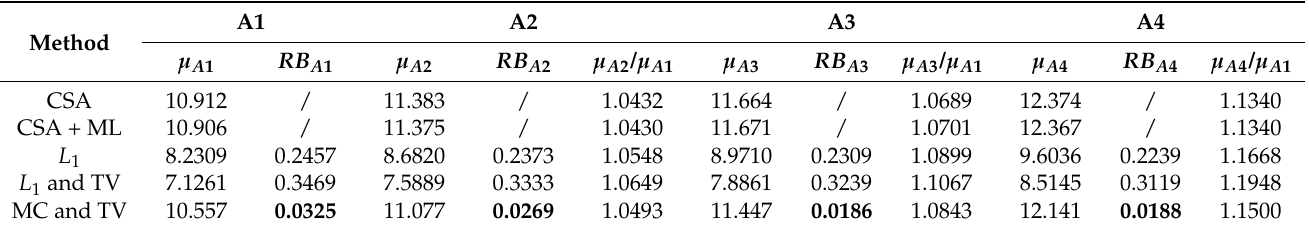
Table 1. The relative bias and relative relationship of four areas after relative normalization in experiment 1 for the five